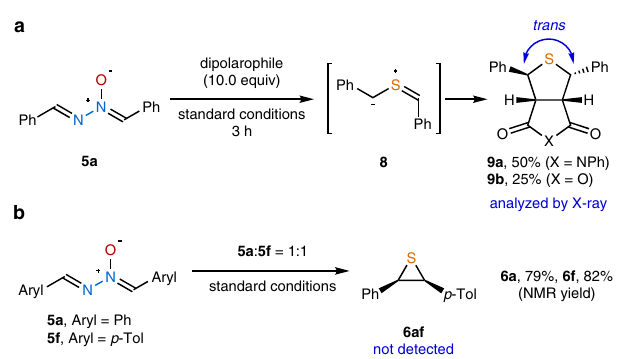
Fig. 5 | Mechanistic experiments. a Trapping the trans -thiocarbonyl ylide inter- mediate with dipolarophiles. b Crossover experiment with two different aldazine N -oxides.